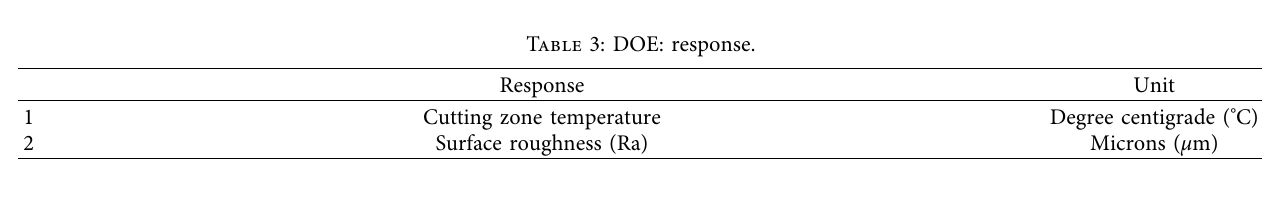
Table 4: Constant factors in the experiments.